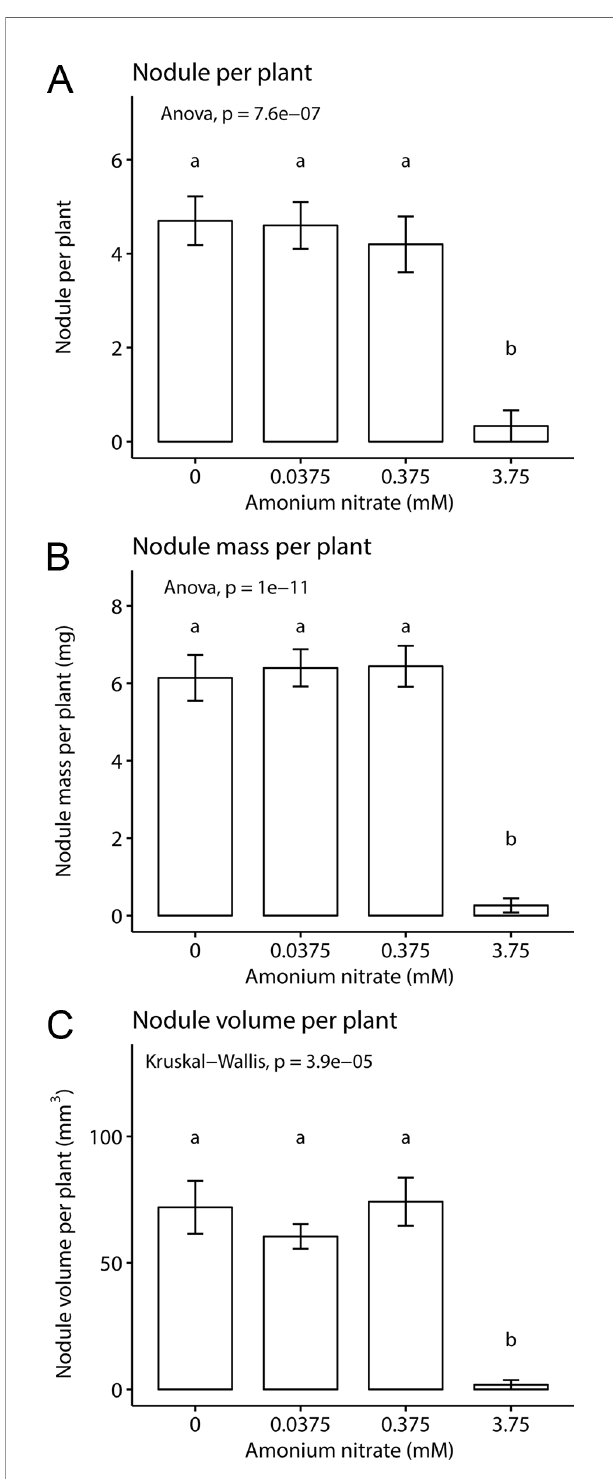
FIGURE 2 | Inoculated Parasponia andersonii nodulation under four nitrogen levels. (A) Mean nodule number per plant. (B) Mean nodule fresh weight per plant. (C) Mean nodule volume per plant. Letters represent groups signi fi cantly different from each other (ANOVA, Tukey HSD test and Kruskal test, Dunn ’ s test). Error bars show standard